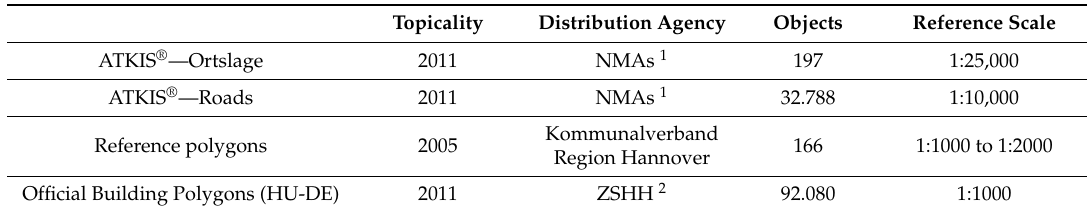
Table 2. Overview of input data.